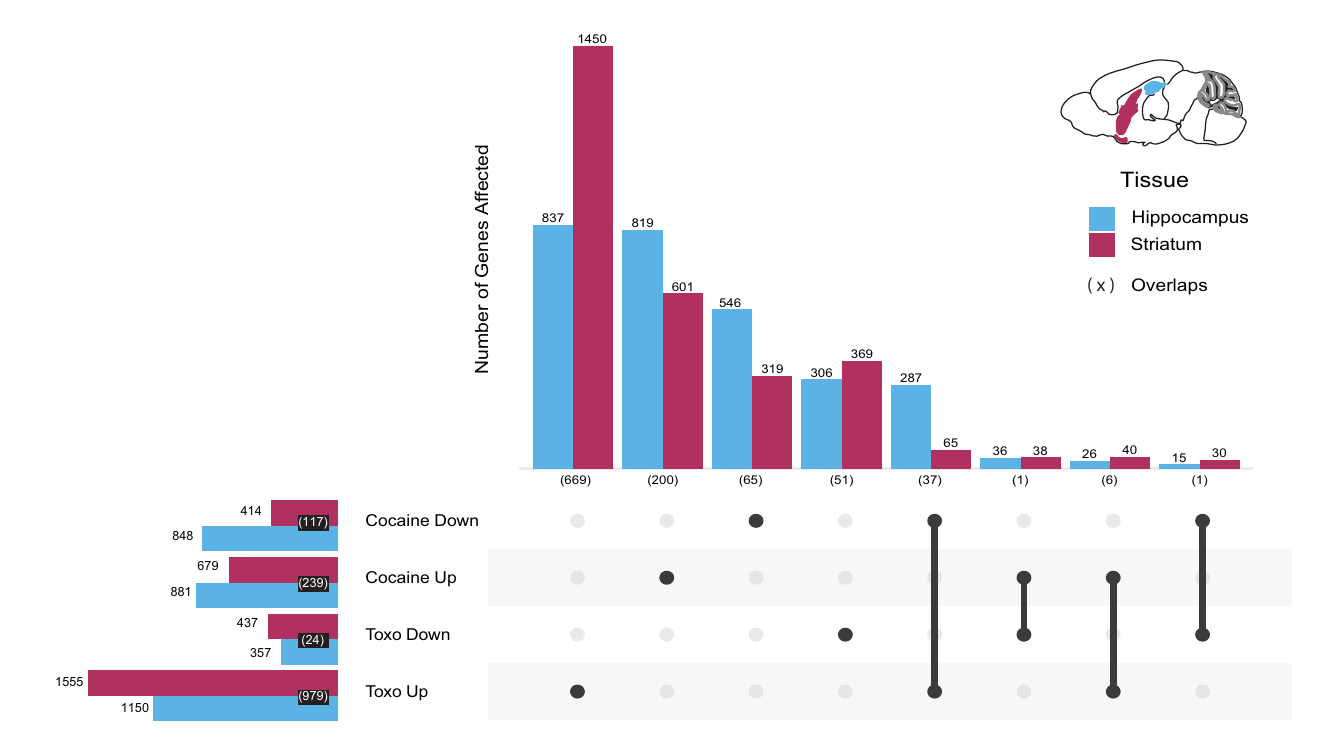
Fig 3. Expression of differentially expressed genes responding to cocaine and T . gondii infection. The upset plot shows the number of differentially expressed genes by response, with overlaps by treatment category and tissue. The horizontal bars to the left indicate the total number of differentially expressed genes associated with each of the four conditions. The filled in dots in the dot matrix, together with the corresponding vertical bars then show how these genes are distributed. For example, of the 1150 differentially expressed genes in the Hippocampus associated with “Toxo Up”, 837 are only associated with the “Toxo Up” dataset (1 st column), while 287 are shared with the “Cocaine Down” dataset (5 th column) and 26 are shared with the “Cocaine Up” dataset (7 th column). Within categories, tissue overlaps are indicated (bracketed). Genes represented are mouse genes identified as being significantly differentially expressed (likelihood ratio test, FDR < 0.1) across pairs of conditions within a